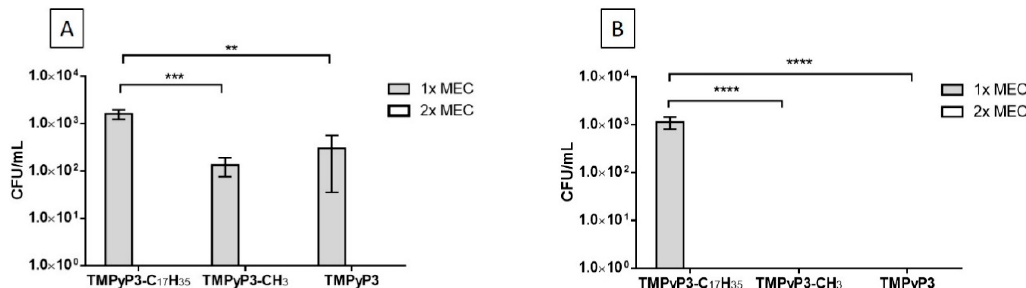
Figure 6. Co-cultivation of L pneumophila and A. castellanii in the presence of 1× MEC and 2× MEC concentrations of each porphyrin after 10 min (total dose 12 J/cm 2 ) ( A ) (control: CFU/mL = 2.45 × 10 8 ± 2.29) and 30 min (total dose 36 J/cm 2 ) ( B ) (control: CFU/mL = 82.14 × 10 8 ± 2.24) irradiation with violet light. The data are presented as an average of triplicate measurements, and error bars are representing SD; ** p = 0.001, *** p = 0.002, **** p < 0.0001.